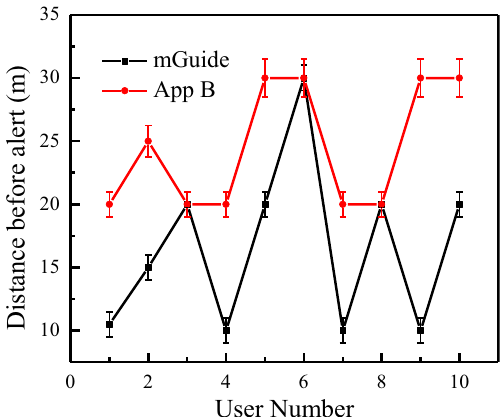
Fig. 8 A graph of distance before notification for different users on the mapped routes; for the mGuide and App